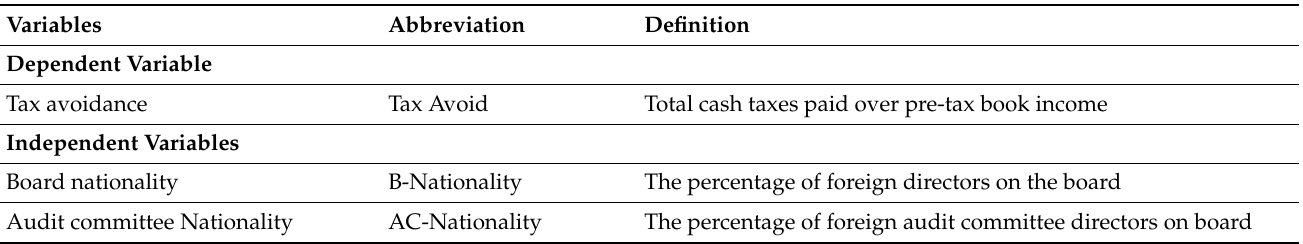
Table 1. Variable measurement and